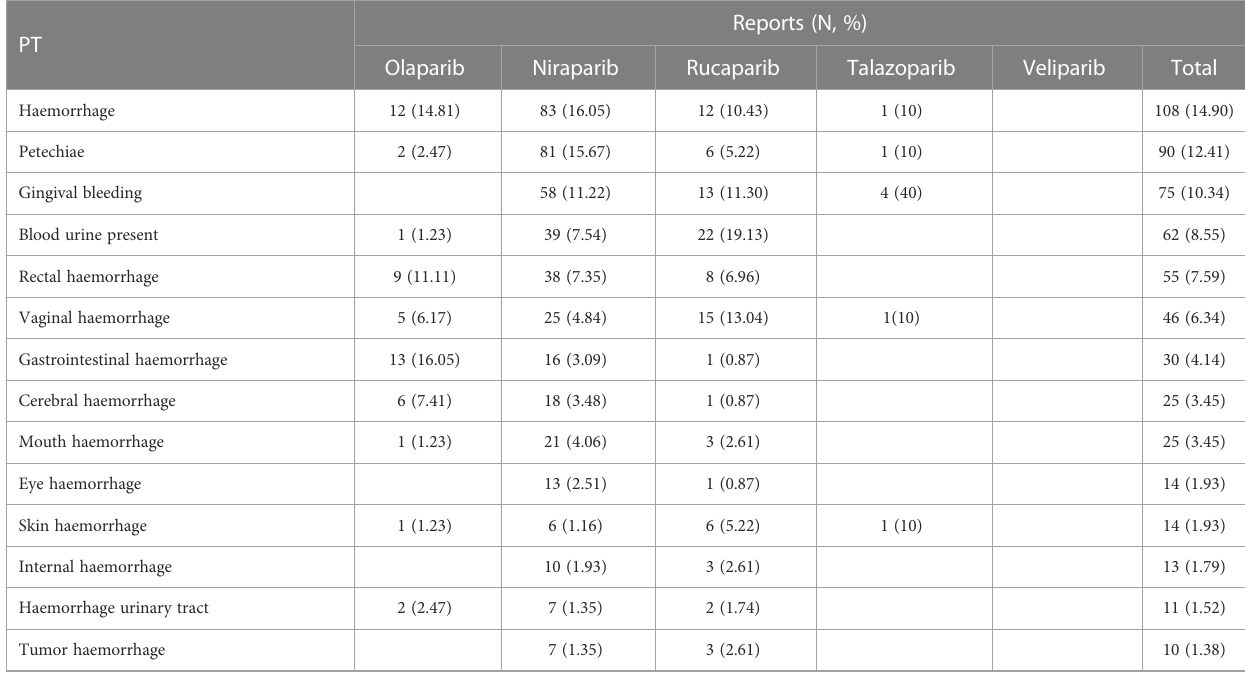
TABLE 4 Detailed PT-related to haemorrhages-related adverse events associated with different